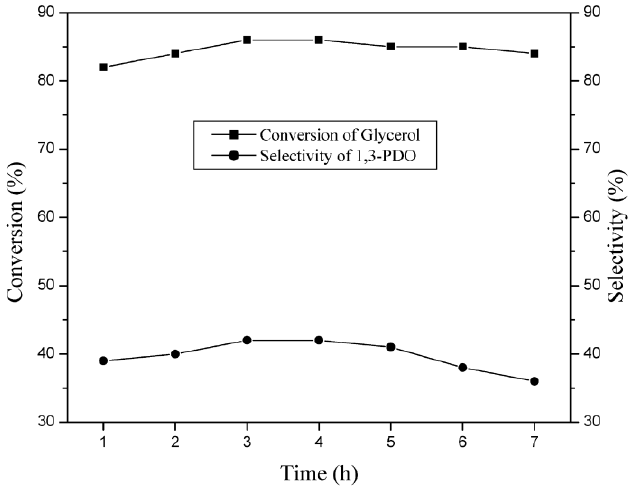
Figure 20. The glycerol conversion and selectivity to 1,3-PG employing Pt/WO x /SBA-15 catalysts. Reaction conditions: 210 °C, 0.1 MPa H 2 , 1.02 h − 1 WHSV. Reproduced from [140] with permission from the American Chemical Society (ACS).